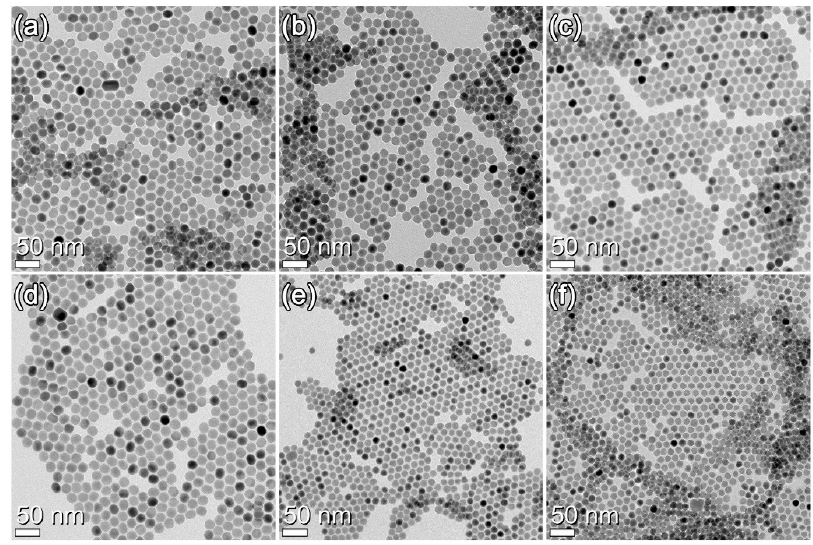
Figure 2. TEM images of NaYF 4 :Nd (x%),Yb (10%) core DSNPs with various Nd 3+ concentrations of ( a ) 10%, ( b ) 20%, ( c ) 25%, ( d ) 30%, ( e ) 40%, and ( f ) 50%.